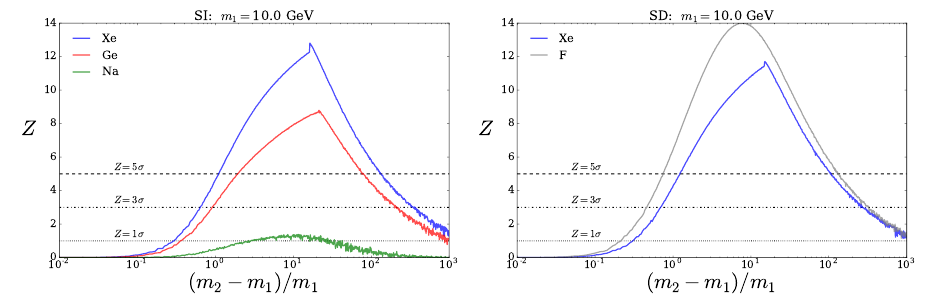
Figure 3. Significance Z with which the median experiment can reject the one-DM hypothesis in favour of the two-DM hypothesis as a function of the mass splitting ( m 2 − m 1 ) / m 1 , for fixed m 1 equal to 10 GeV. We show as dotted, dash-dotted and dashed (black) horizontal lines the 1, 3 and 5 σ C.L. The left panel shows the SI targets xenon (in blue), germanium (in red) and sodium (in green). The right panel shows the SD targets fluorine (in grey) and xenon (in